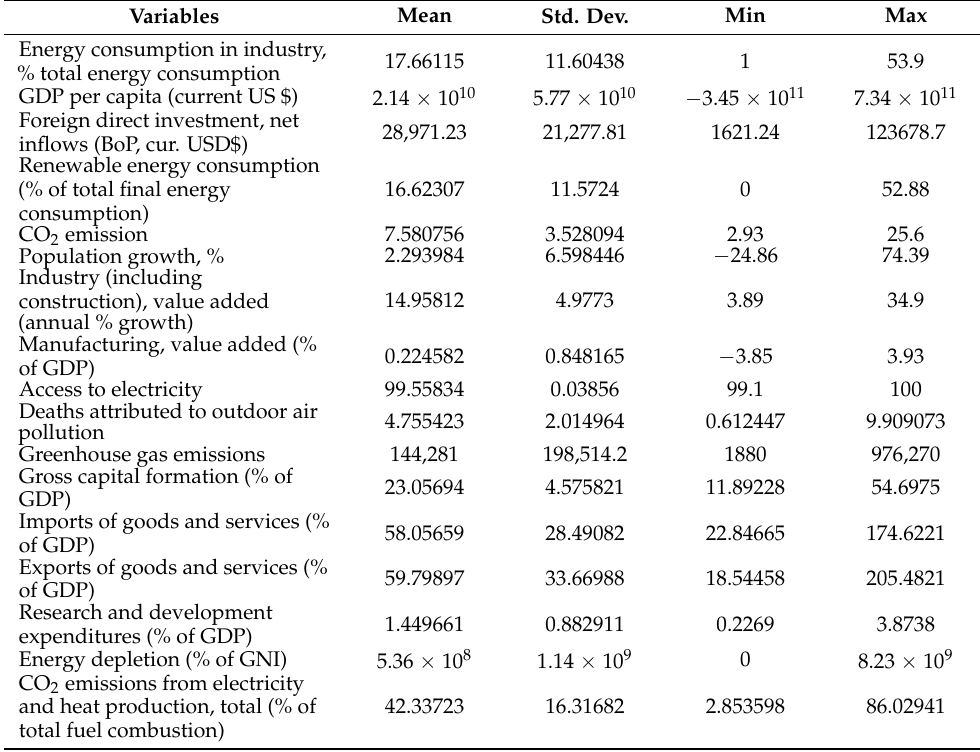
Table 2. Definitions of variables and descriptive statistics for all